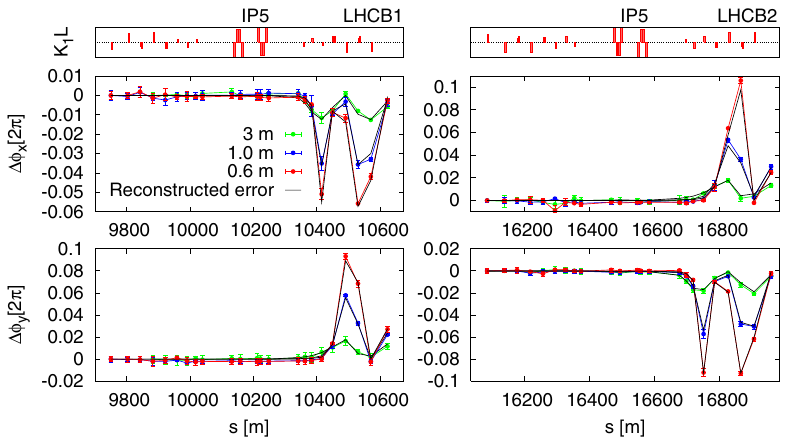
FIG. 6. Illustration of the segment-by-segment technique applied to IR5 simultaneously to the two beams and three different (cid:1) (cid:1) . The black lines show the reconstructed error model.